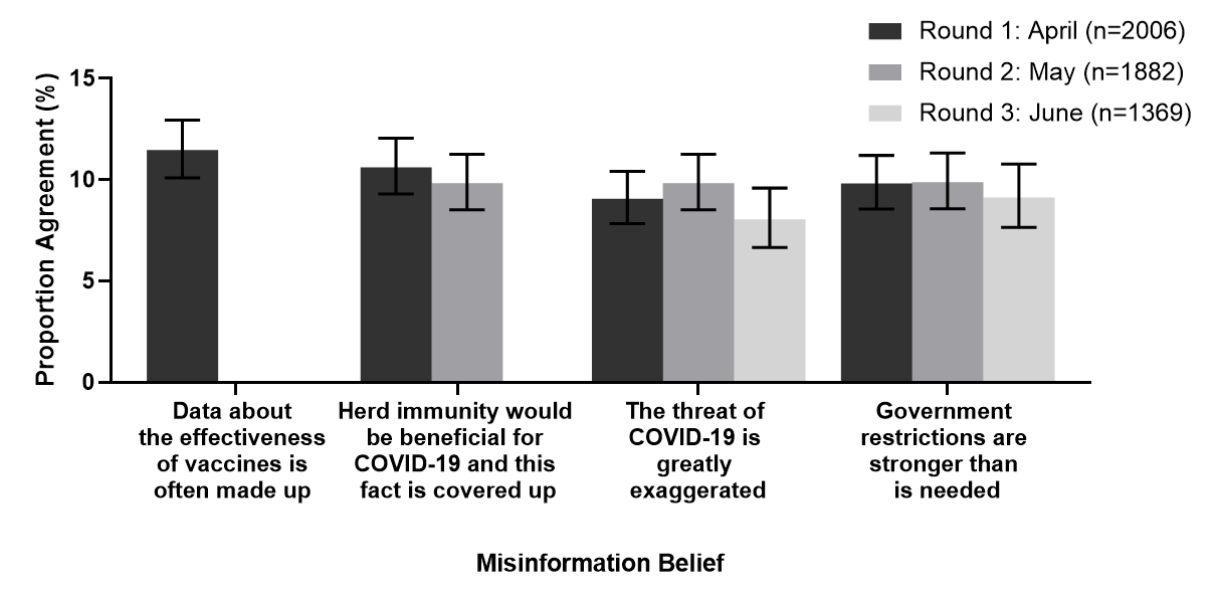
Figure 1. Prevalence of agreement (i.e., responding as somewhat agree (5) to strongly agree (7) on the 1 to 7 Likert scale) with misinformation beliefs by study month. Error bars indicate 95% confidence intervals.].